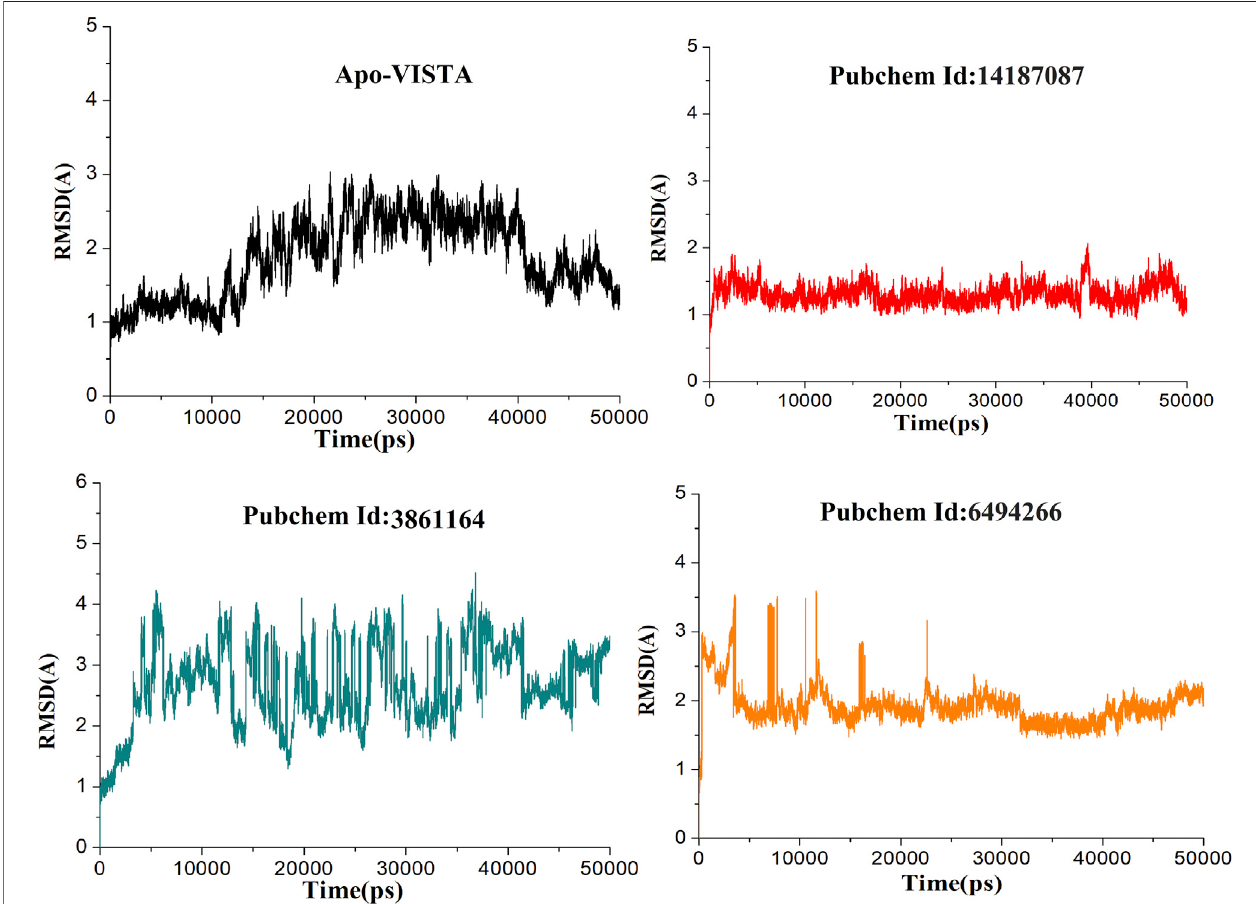
FIGURE 4 | RMSD of all simulated systems as a function of time (Apo-VISAT: black, PubChem ID: 14187087-VISTA: red, PubChem ID: 3861164-VISTA: green, and PubChem ID: 6494266-VISTA: